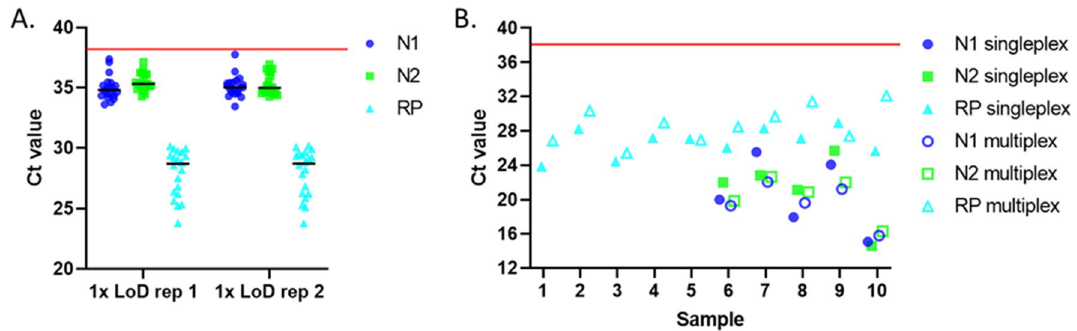
Figure 3. SARS-CoV-2 RT-PCR multiplex assay development. Assay detects 2 sequences (N1 and N2) from SARS-CoV-2 and a human RNA (RP) as an internal extraction control. ( A ) Mock clinical samples created by spiking SARS-CoV-2 synthetic RNA at the level of 1 × LoD into individual negative nasopharyngeal samples. N = 20 per technical replicate. The black lines denote the means for each target and replicate. The red line denotes the Ct cutoff (38) for a positive result. ( B ) 5 negative and 5 positive clinical samples were assessed and compared to the singleplex detection. Samples were blinded to assay personnel. The red line denotes the Ct cutoff (38) for a positive